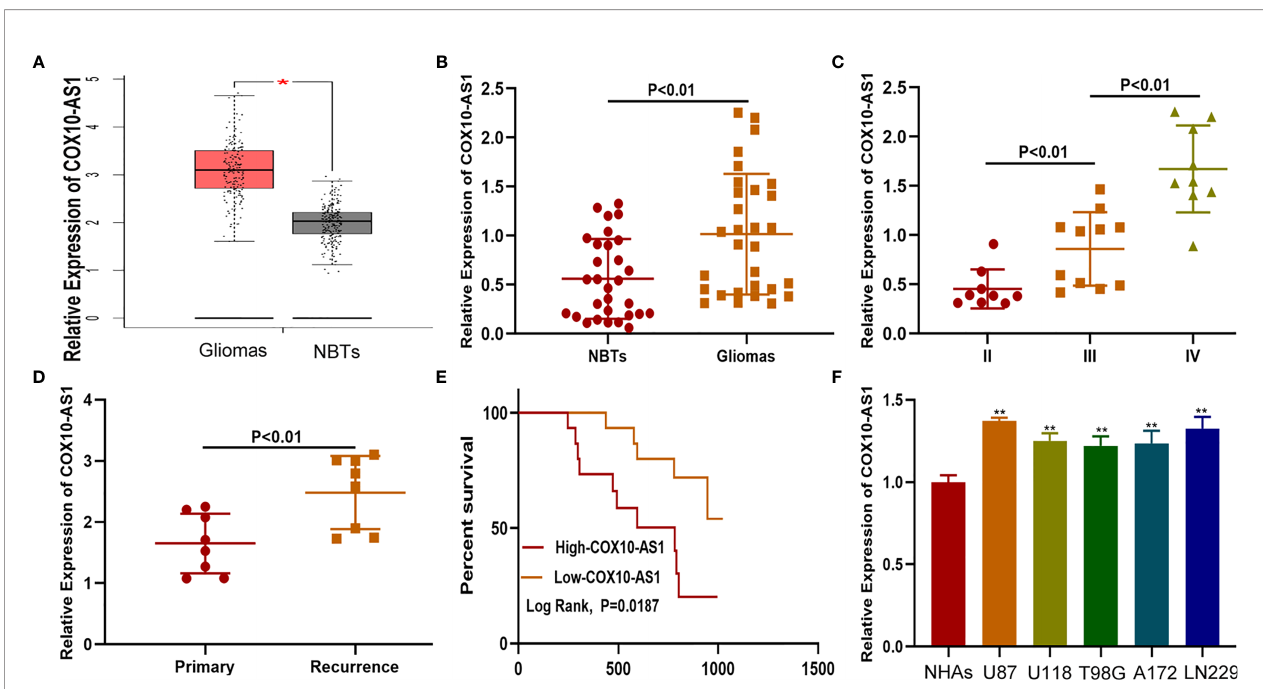
FIGURE 1 | COX10-AS1 is upregulated in glioma tissues and cell lines. (A) The relative expression of COX10-AS1 in GEPIA. (B) The relative expression of COX10- AS1 in clinical specimens. (C) The relative expression of COX10-AS1 in different grade of glioma. (D) The relative expression of COX10-AS1 in clinical specimens from patients with primary and recurrent glioma. (E) Kaplan – Meier curve analysis of the correlation between COX10-AS1 expression and overall survival from our clinical data. (F) The relative expression of COX10-AS1 in NHAs and glioma cell lines. *P < 0.05, **P <